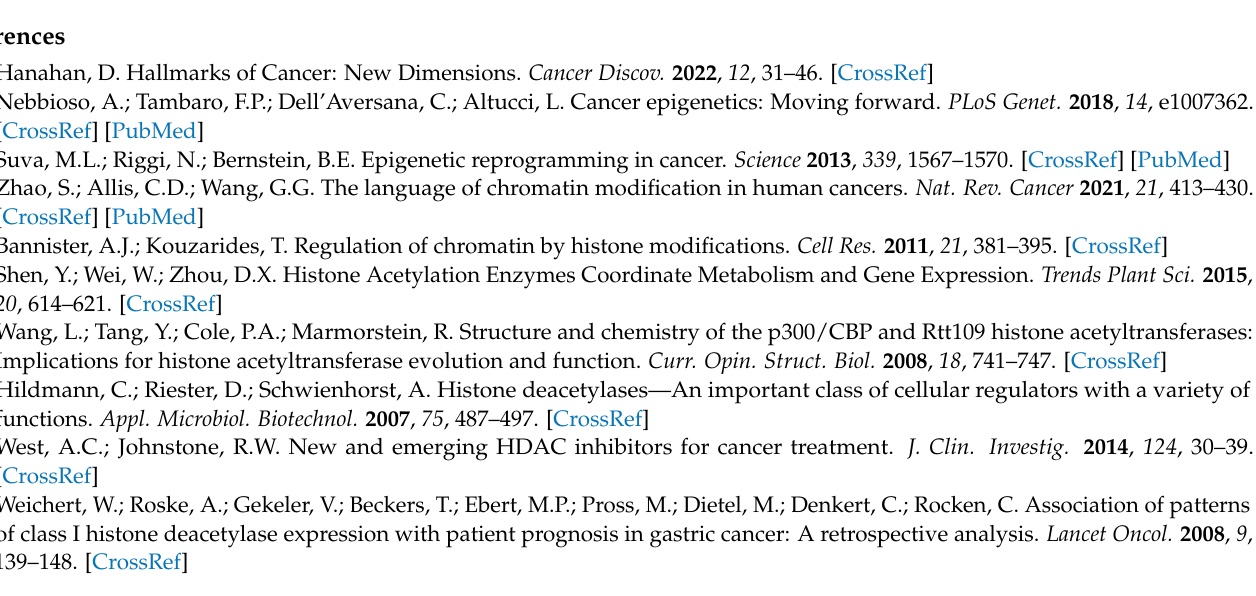
Supplemental Figure S1: The correlation of HDAC1 and CREPT in human cancers. A. CREPT expres- sion is positively correlated to HDAC1 at the protein level in breast cancer cells. The endogenous protein levels of HDAC1 and CREPT in breast cancer cell lines (T47D, MCF7, MDA231) and epithelial cell (MCF10A) were shown. β -actin was used as a loading control. BC. The mRNA level of HDAC1 and CREPT in breast cancer cells compared with the normal cell. The mRNA levels were normal- ized to fold change relative to β -actin. D. HDAC1 and CREPT are highly correlated in TCGA (The Cancer Genome Atlas) database. BRCA represents breast invasive carcinoma, LUAD represents lung adenocarcinoma, PRAD represents prostate